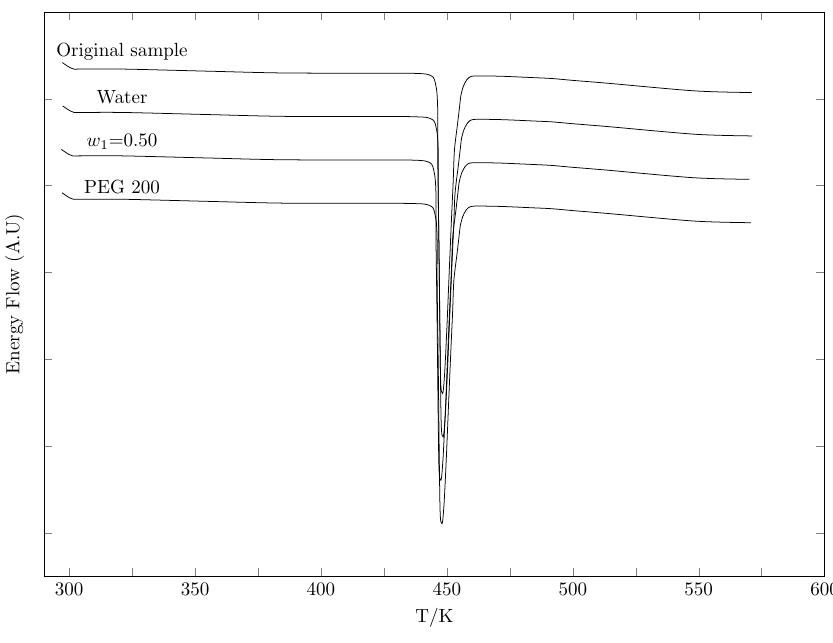
Figure 5. DSC Spectra of